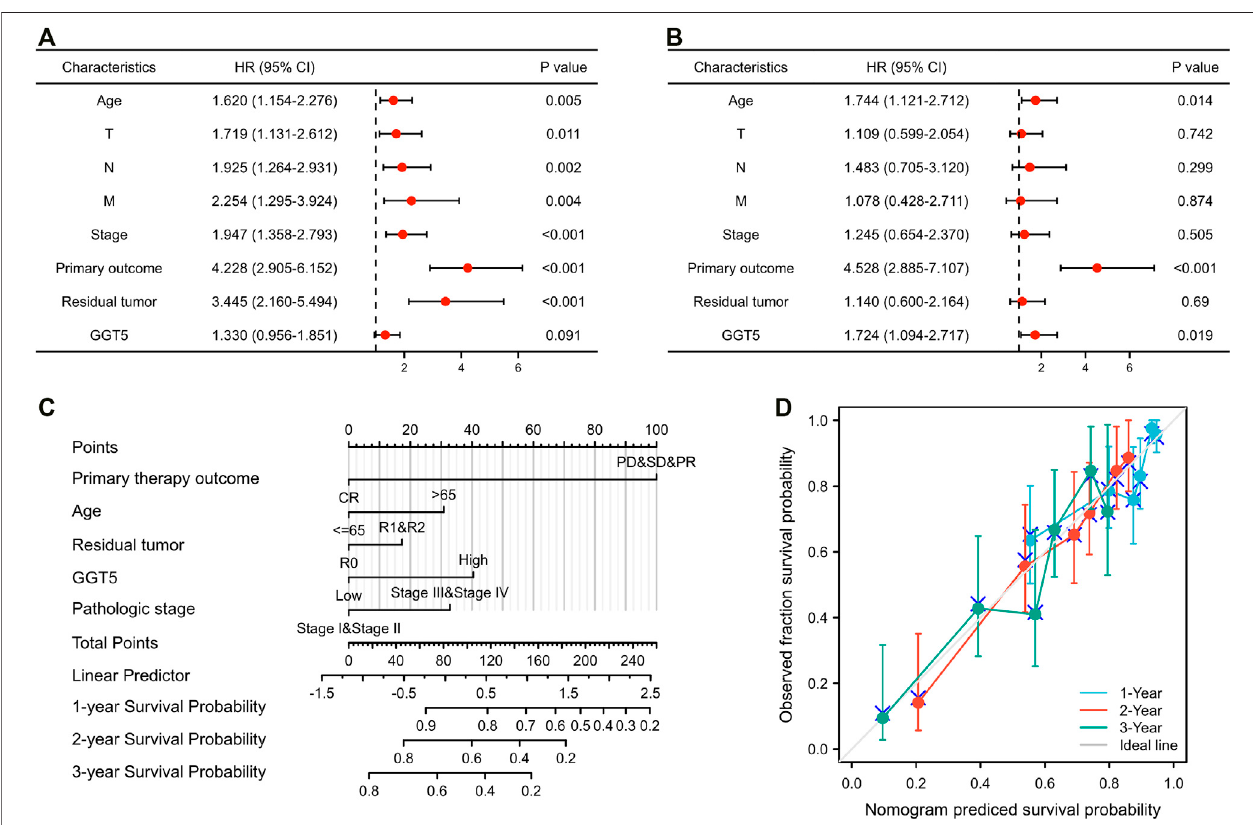
FIGURE 4 | The prognostic factor analysis and nomogram model construction. The results of univariate (A) and multivariate Cox regression (B) for the overall survival of GC patients are displayed in the form of forest plots. (C) A nomogram model was constructed for predicting the 1-year, 2-years, and 3-years overall survival probability of GC patients. (D) Calibration curves for the nomogram model predicting the probability of the 1-year, 2-years, and 3-years overall survival of GC patients.